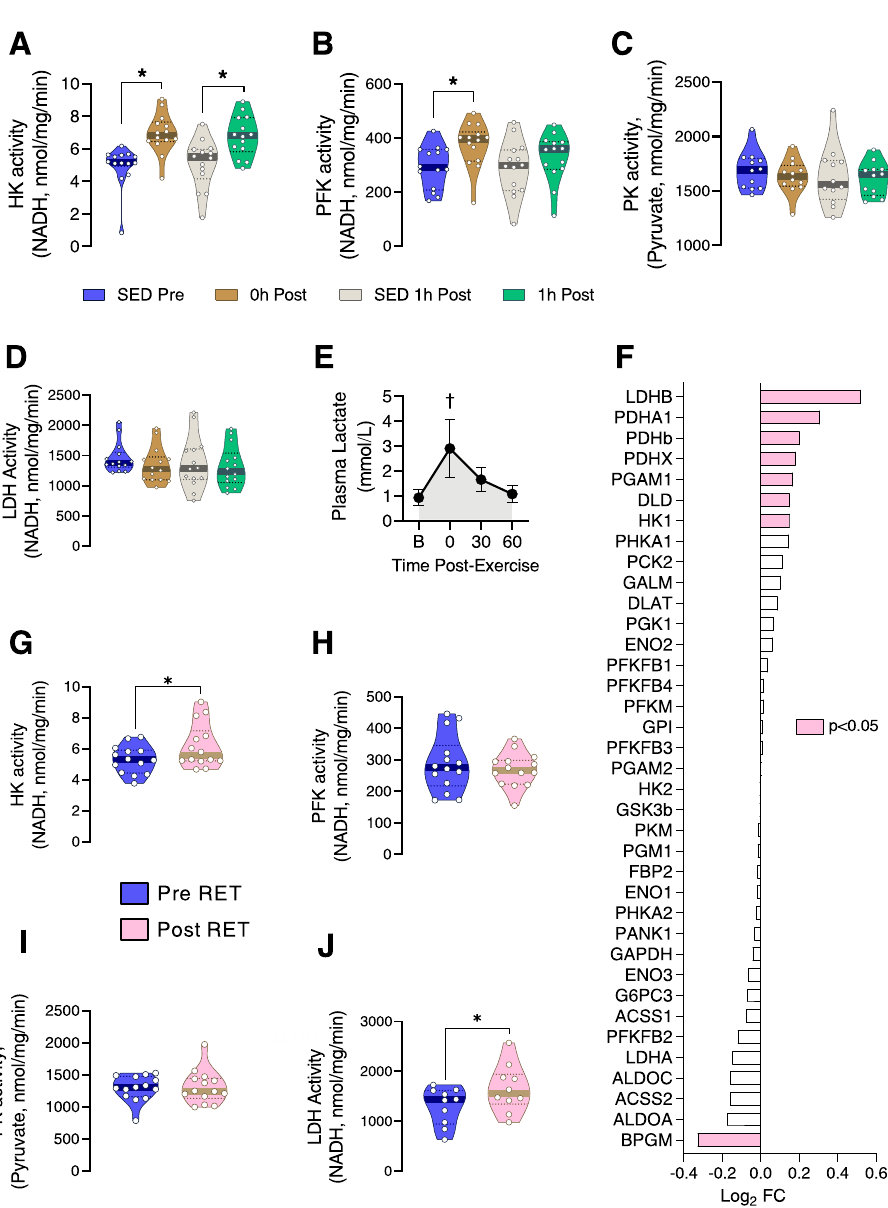
Fig. 1 Resistance exercise upregulates glycolysis in human skeletal muscle. A – D The enzyme activity of hexokinase (HK), phosphofructokinase (PFK), pyruvate kinase (PK), and lactate dehydrogenase (LDH) were analyzed from muscle biopsies of healthy participants before (SED Pre), within 10 min after (0 h Post), and 1 h after (1 h Post) a one-legged resistance exercise (RE) bout ( n = 14 for HK, PFK and LDH; n = 12 for PK). Time-matched control muscle samples were obtained from the non-exercised leg at 1 h post-RE (SED Post). * P < 0.05 vs. SED in each group. One-way ANOVA was used with multiple comparisons. E Plasma lactate was measured at baseline (B), immediately post-exercise (0), 30 min post-exercise (30), and 60 min post-exercise (60) to represent the “ spill over ” of lactate from muscle to blood ( n = 17). † indicates a signi fi cant difference between the immediate post-exercise and baseline lactate samples ( P < 0.05). F RNA-Seq data for glycolysis-related genes in muscle after resistance exercise training (RET) ( n = 18). Data were analyzed from RNA-Seq results presented in our previous publication 18 . G – J Muscles were obtained before (pre-RET) and after (post-RET) 12 weeks of RET and subsequently analyzed for HK, PFK, PK, and LDH activity ( n = 14 for HK, PFK, and PK; n = 10 for LDH). * P < 0.05 vs. pre-RET. Paired two-tailed t -test was used. Values are expressed as individual data points, Log 2 FC, or mean ± SD. Signi fi cant labeled P -values in each panel from left to right are as follows: panel A = 0.001 and 0.007; panel B = 0.004; panel E = < 0.001; panel G = 0.009; panel J =